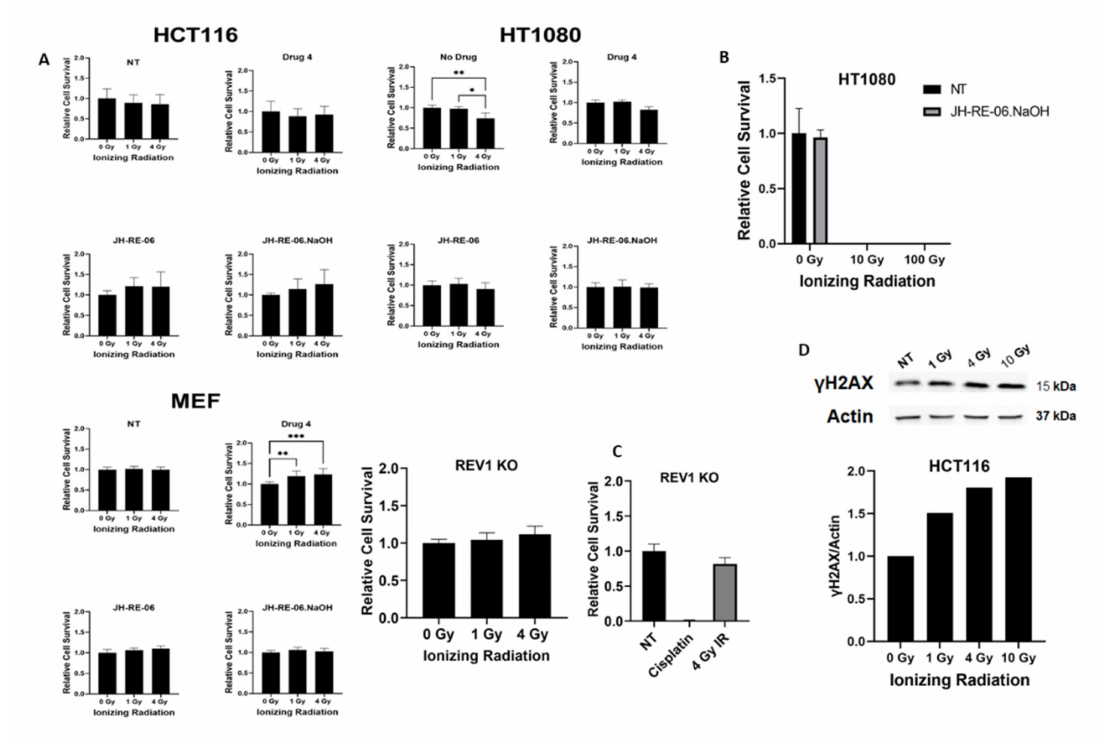
Figure 1. REV1 inhibition does not sensitize cancer cells to ionizing radiation. ( A ) Relative cell survival of HCT116 (colorectal), HT1080 (fibrosarcoma), mouse embryonic fibroblasts (MEF), and REV1 KO (knockout; MEFs) cells in response to increasing amounts of ionizing radiation at doses of 1 and 4 Gy and REV1 inhibitor drugs at a 1 µ M concentration: 4 (7922759), JH-1 (JH-RE-06), and JH-2 (JH-RE06.NaOH). ( B ) Relative cell survival of HT1080 cells with 0, 10, and 100 Gy. ( C ) Relative cell survival in REV1 KO cells after treatment with increasing doses of IR at 0, 1, and 4 Gy (left graph) and with 10 mM cisplatin and 4 Gy of radiation (right graph). ( D ) Western blot showing γ H2AX in HCT116 cells treated with 1, 4, and 10 Gy of radiation at 24 h. Graph shows the relative quantification of the Western blots. p -Values are * p < 0.05, ** p < 0.01, and *** p < 0.001. Error bars represent standard deviations. p -Values were calculated by 2-way ANOVA. N = 6 for all